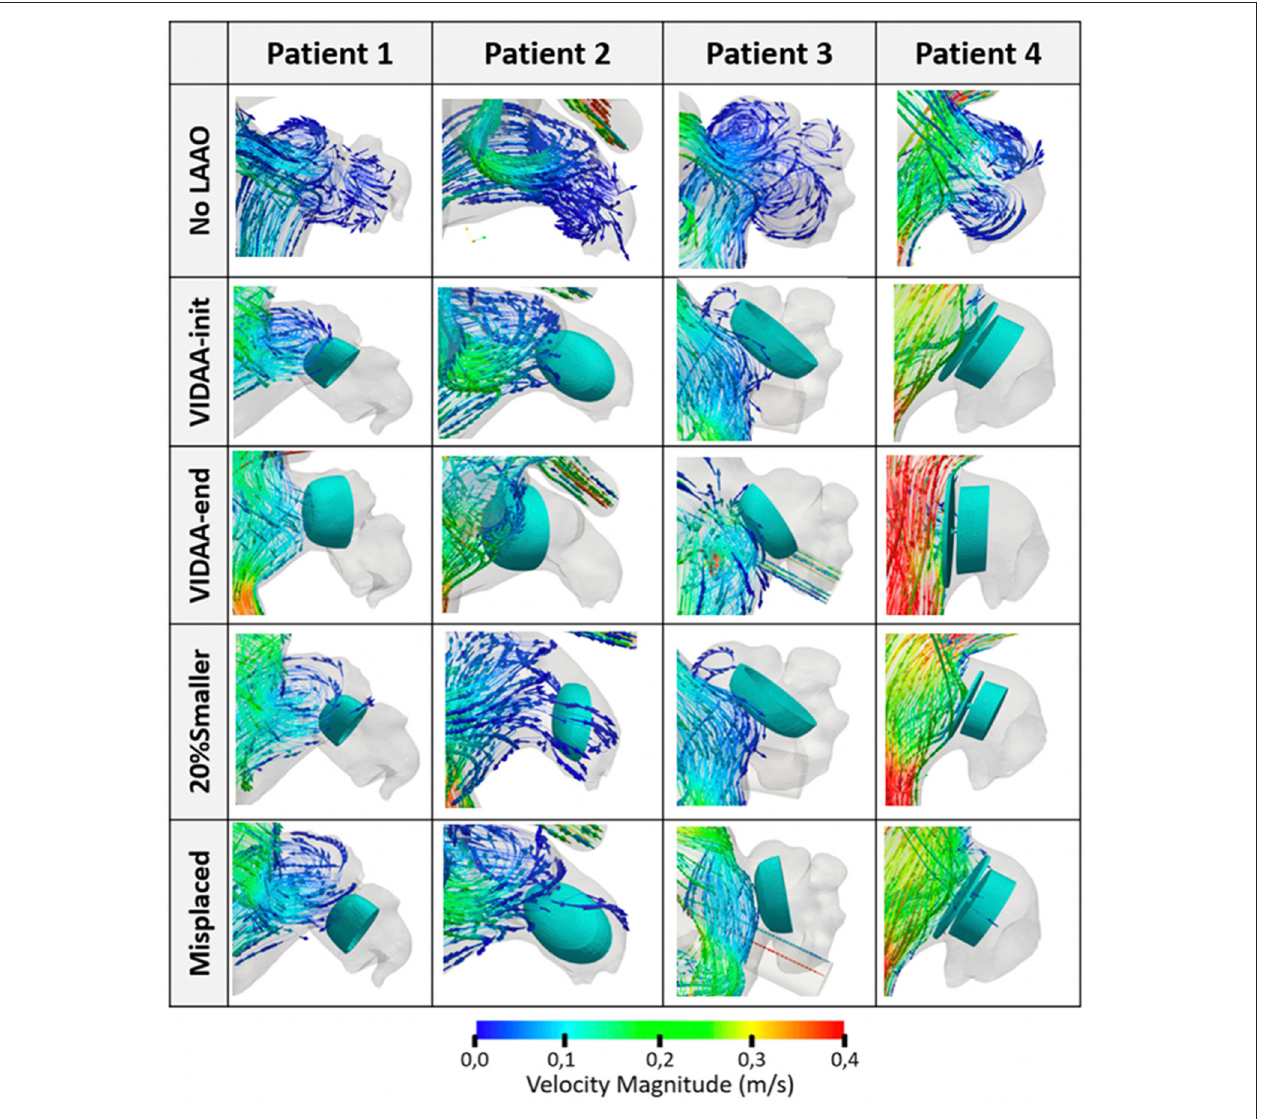
FIGURE 5 | Blood flow streamlines in the left atrial appendage (LAA) from hemodynamics simulations of the four patients under study. Snapshots capture the flow behavior in diastole, when higher velocities are present ( t = 0.55 s). No LAAO: without device; VIDAA-init: device settings from morphological analysis and clinical recommendations; VIDAA-end: device settings after interactive manipulation in VIDAA; 20% smaller: device with a 20% smaller size than VIDAA-init; Misplaced: device with sub-optimal position and orientation.